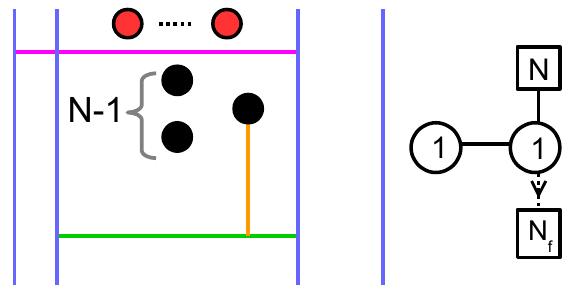
(cid:10) (cid:11) U + U (cid:0) . The partition 1 ; 1 1 ; 0